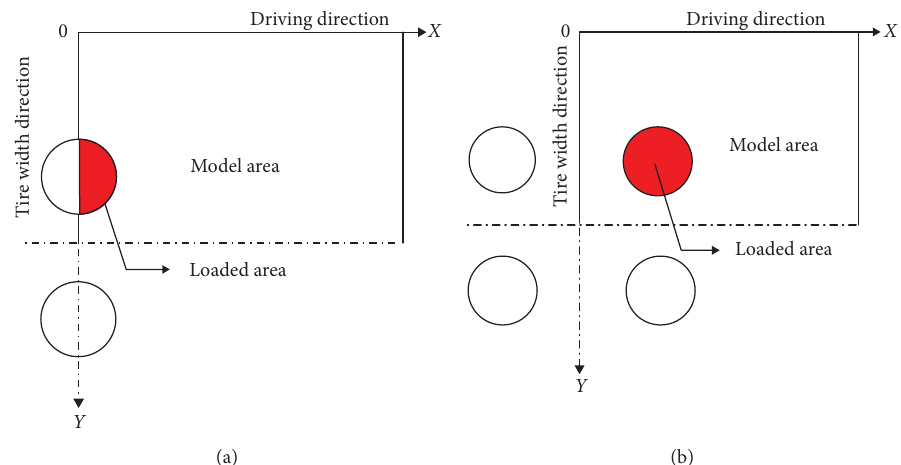
Figure 3: 1/4 symmetry of EverStressFE program model (circular load as an example): (a) single axle dual-wheel; (b) tandem axle dual- wheel.